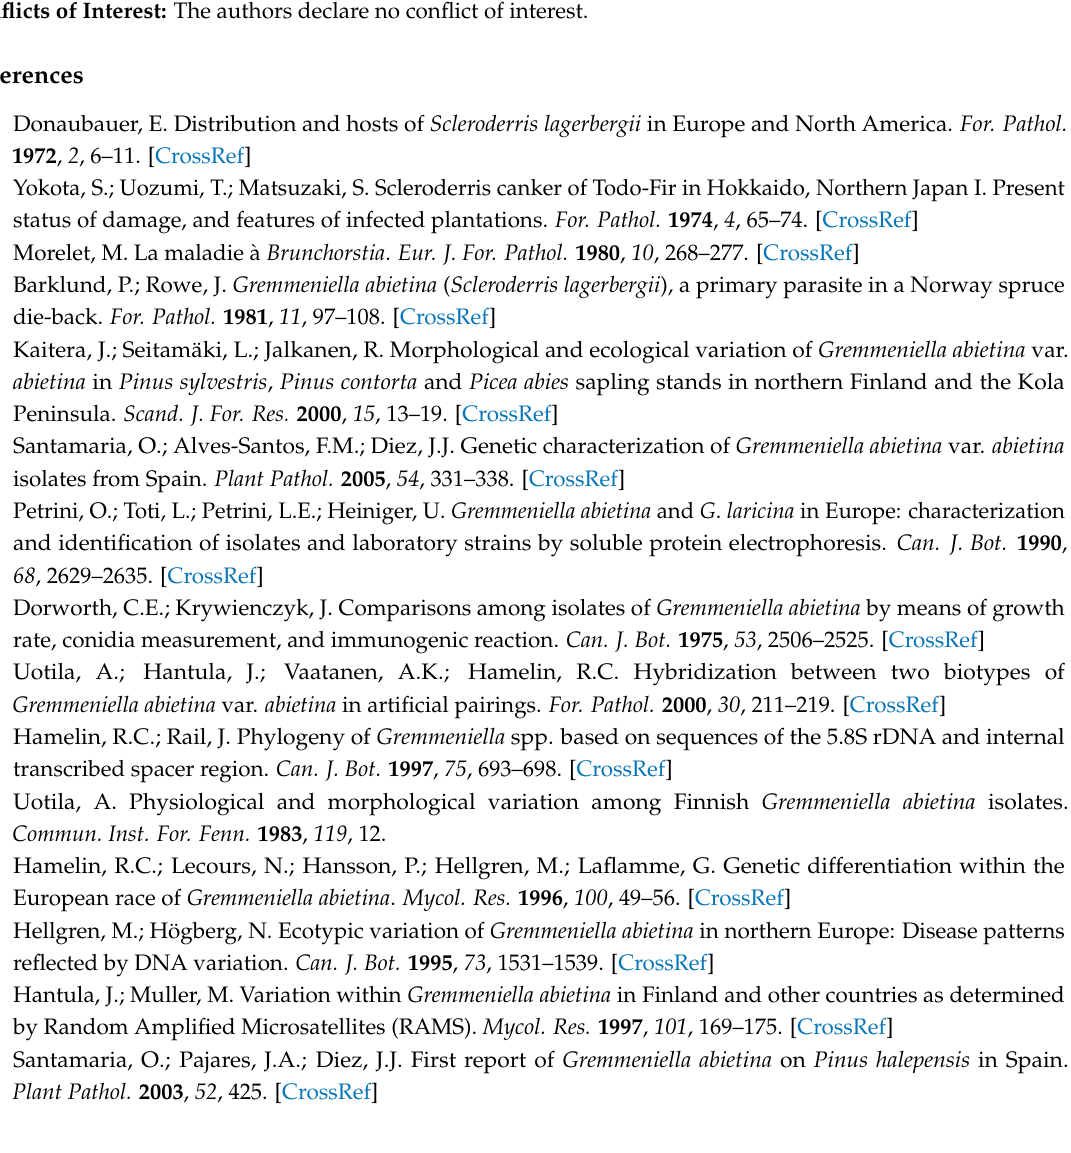
Table S1: Primers used in this study for the determination of the virus